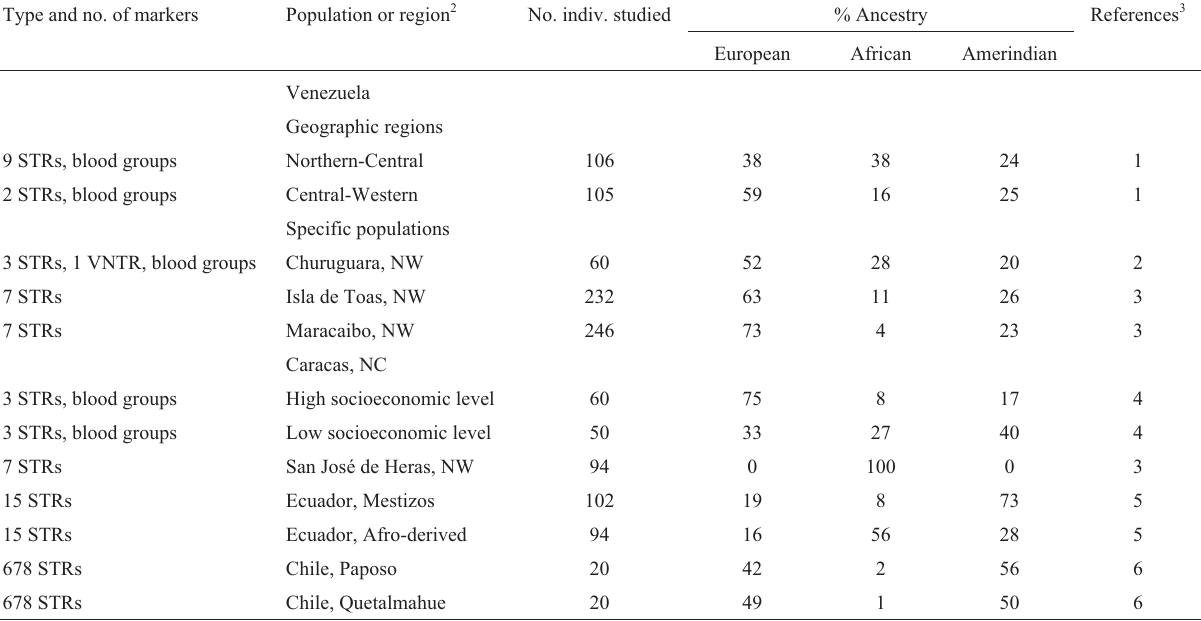
Table 7 - Molecular autosome estimates of parental continental ancestry in populations from three South American countries 1 . Type and no. of